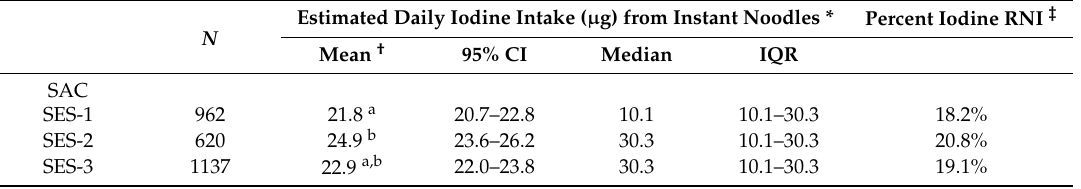
Table 4. Mean and median estimated intakes of iodine ( µ g/day) from the consumption of instant noodles according to respondent group and household SES